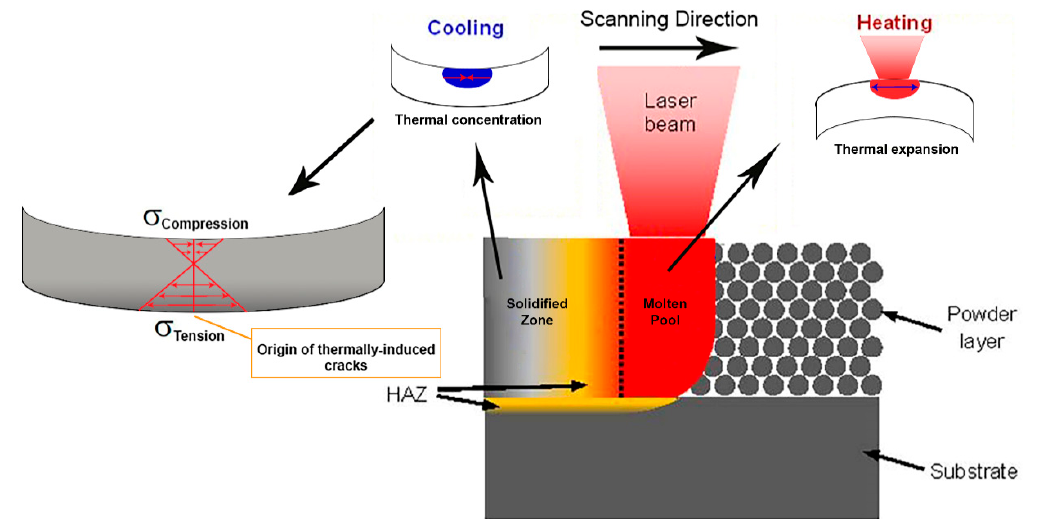
Figure 7. Thermal stresses in SLM and origin of thermally induced cracks (adapted from [29]).